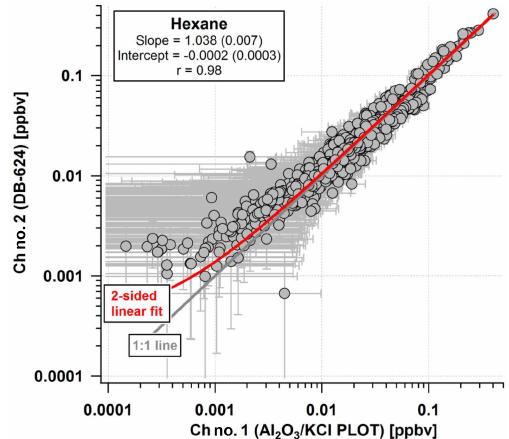
Figure 6. Intercomparison of n-hexane measurements made by the two different channels of iWAS/ACCBAR system during SENEX 2013. Data are shown with error bars based upon total analytical uncertainty presented in Table